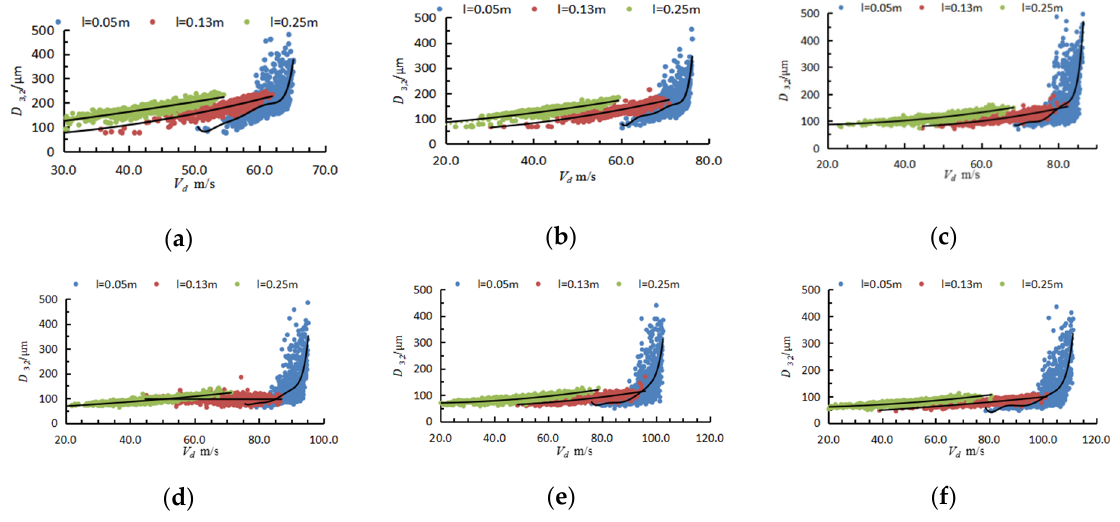
Figure 20. Relation between droplet diameter and velocity in different spray pressure: ( a ) 6 MPa; ( b ) 8 MPa; ( c ) 10 MPa; ( d ) 12 MPa; ( e ) 14 MPa; and ( f ) 16 MPa.